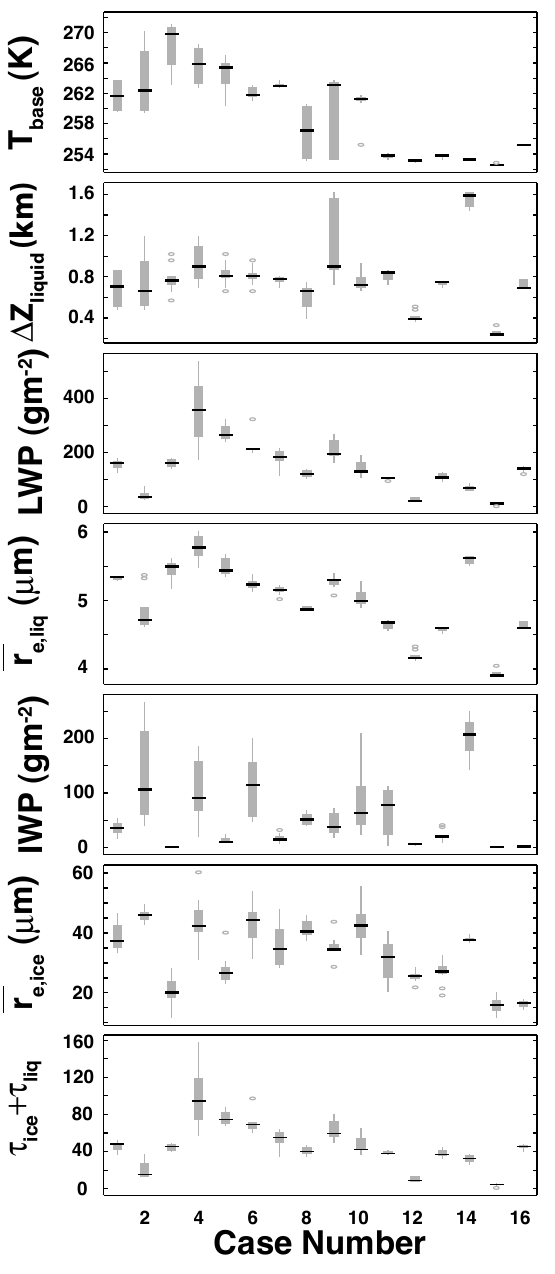
Fig. 2. Distributions of retrieved (top to bottom) cloud base temperature (T base ), liquid cloud thickness ( ∆ Z liquid ), liquid water path (LWP), mean liquid droplet effective radius ( r e,liq ), ice water path (IWP), and mean ice crystal effective radius ( r e,ice ) for all included cases.